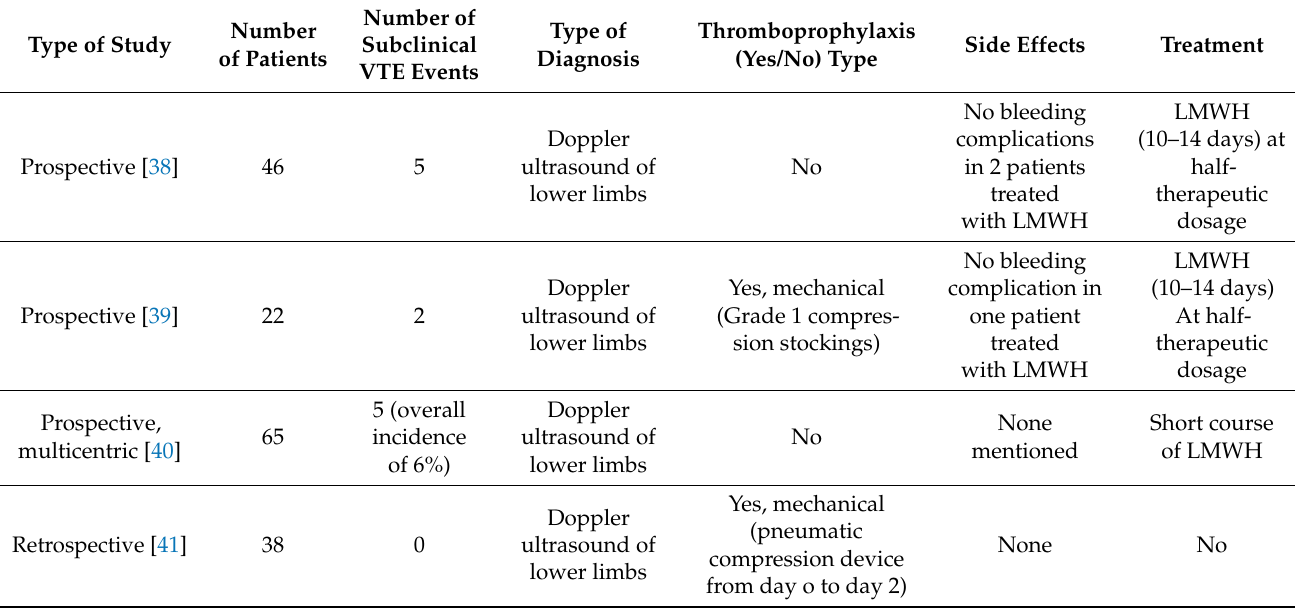
Table 2. Summary of the studies reporting episodes of subclinical deep vein